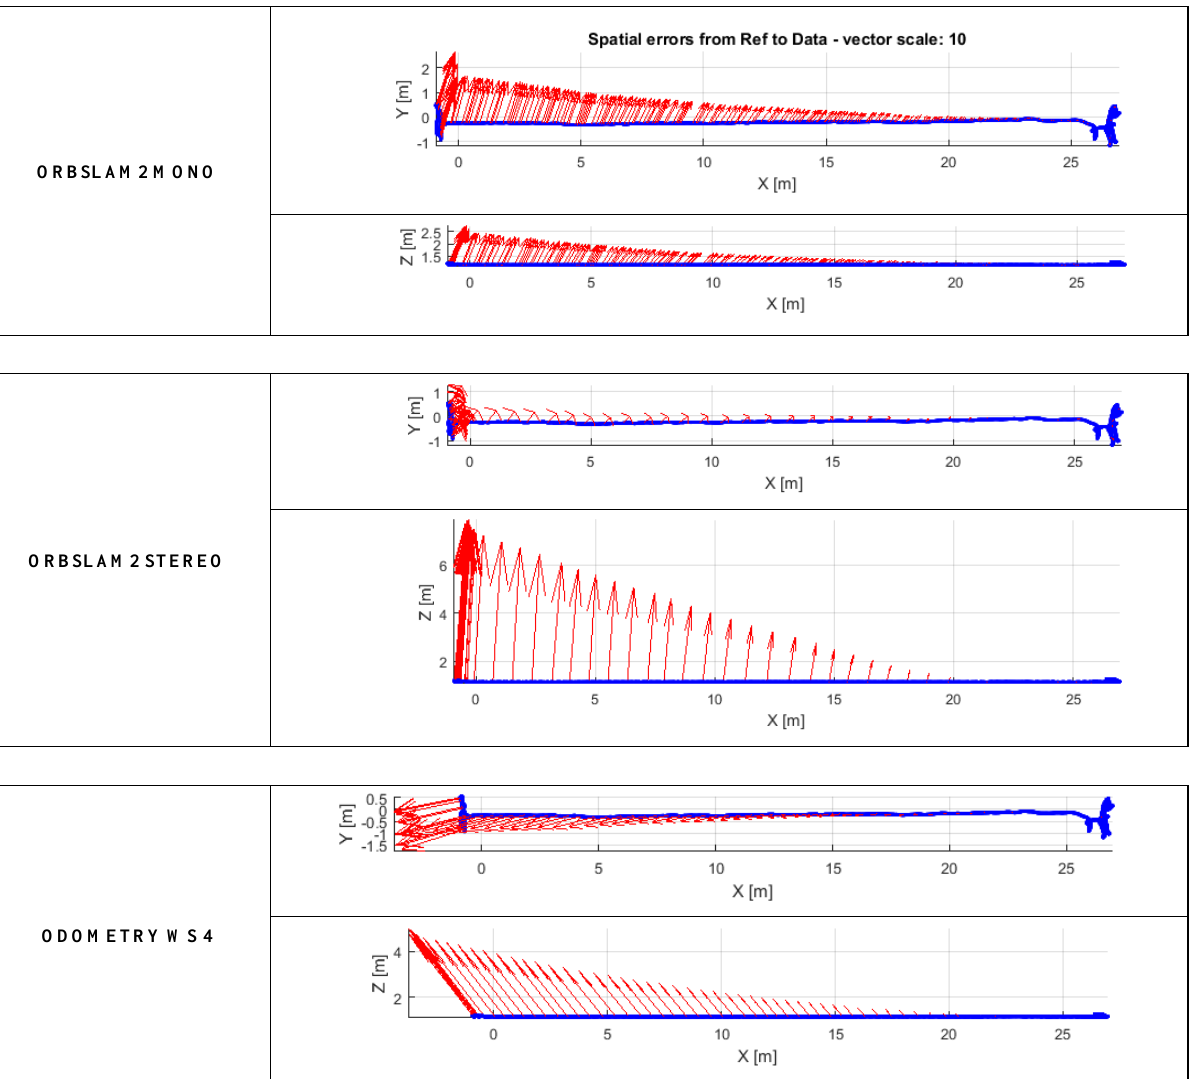
Figure 6. Drift analysis using a local alignment computed on the first third of the sequence, corresponding to the vertical wall of the pool and before the linear section of transect. The vectors indicate the difference between the reference trajectory and the tested